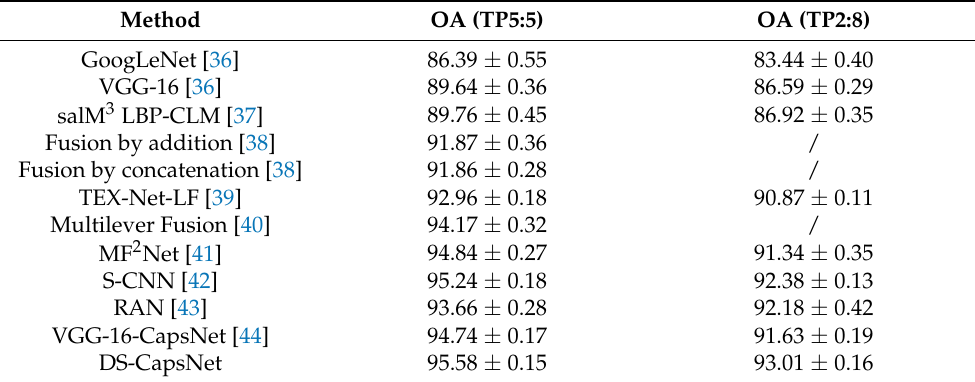
Table 2. OA (%) and SD of different methods under 5:5 and 2:8 training ratios on the AID dataset.